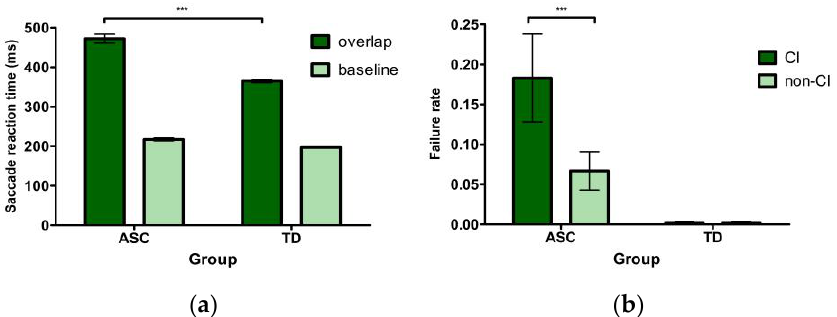
Figure 5. Mean eye movement measures for each group in Experiment 3. ( a ) saccade reaction time by